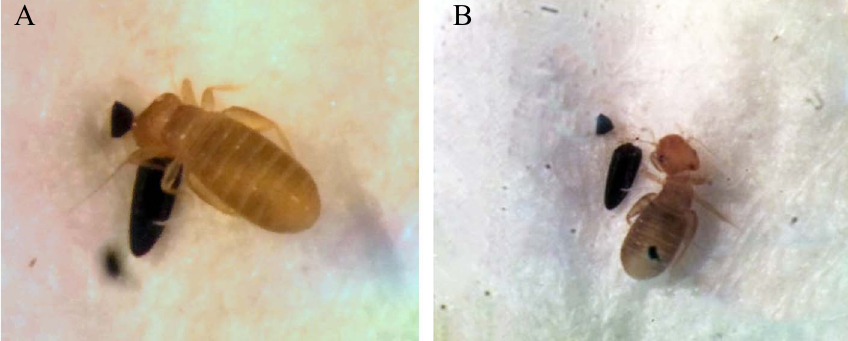
Figure 4. Before (A) and after (B) a psocid meal. Small pieces of the egg chorion seen in the insect ’ s abdomen. Photo by H.